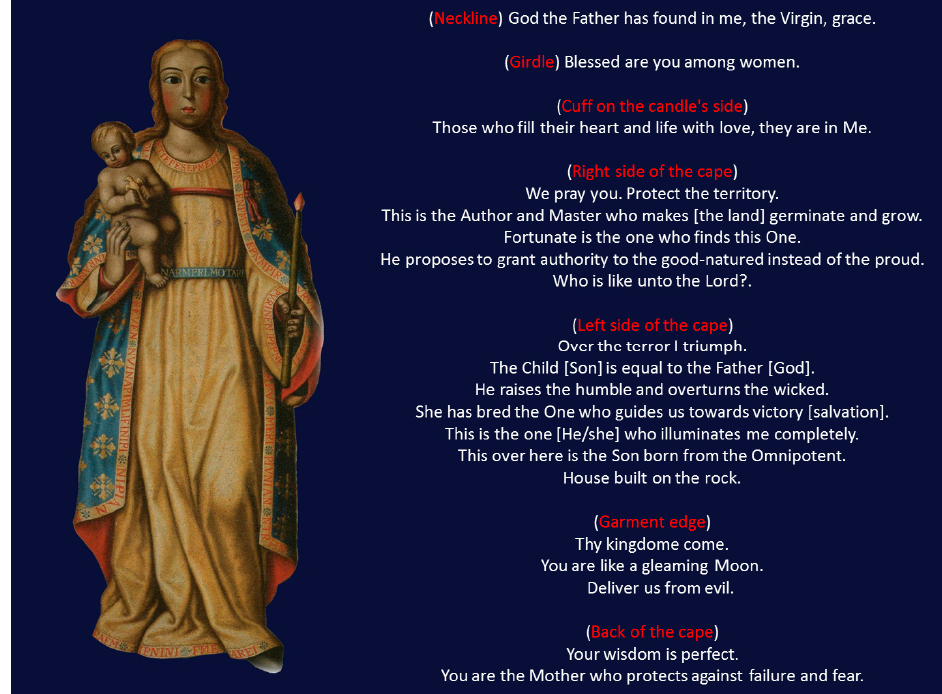
Figure 4. Linguistic decipherment of the lettering on the (original) carving of the Virgin of Candelaria from Tenerife (Canary Islands).